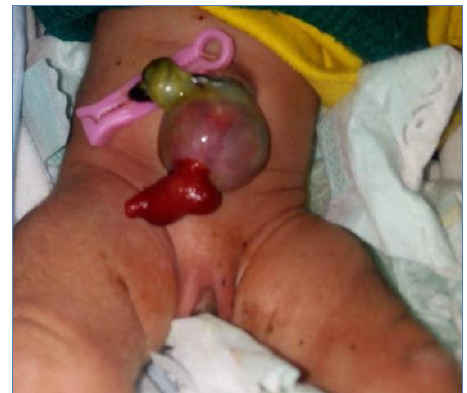
Figure 9: HUC with prolapse of PVID.